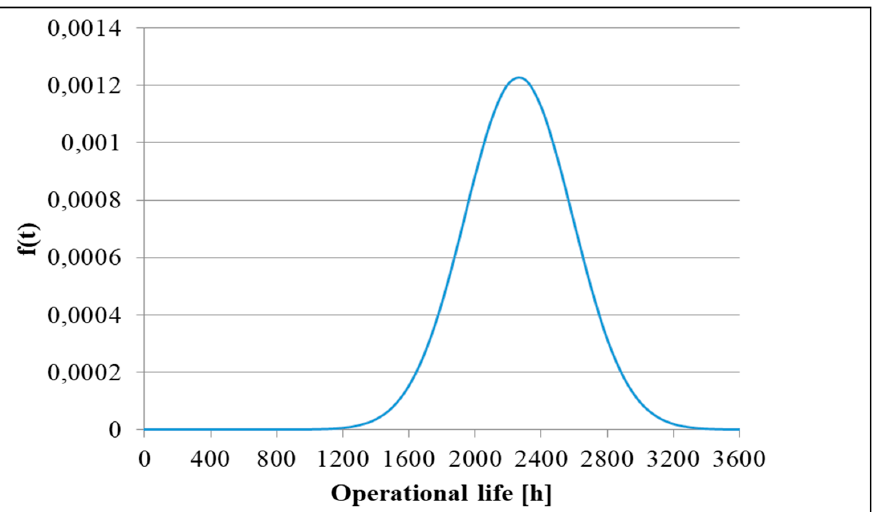
Figure 6. Diagram of the density function of the time when the diagnostic parameter f(t) exceeds the limit state for the 200SGL129Q starter-generator No. 8544XL.